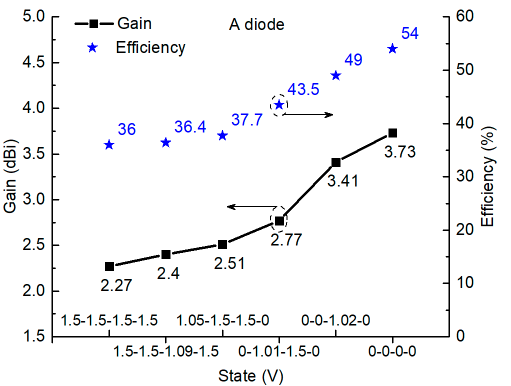
Figure 9. Measured gain and efficiency of the active antenna in two extreme states and four nonlinear states with PIN diode A (MACOM MA4AGBLP912).